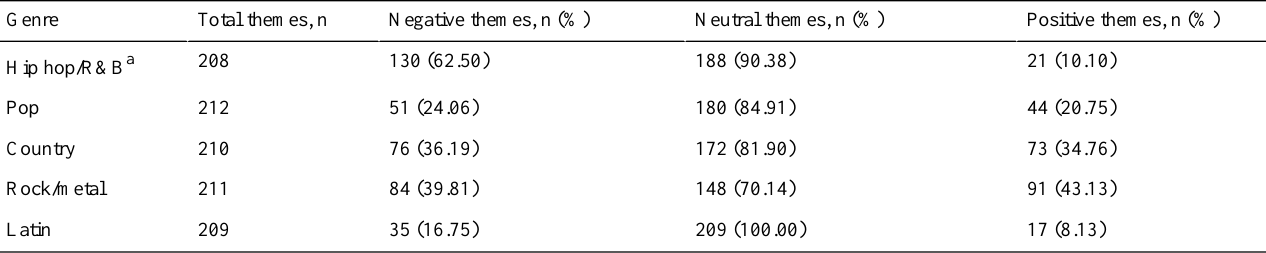
Table 3. Frequency of negative, neutral, and positive themes in lyrics based on